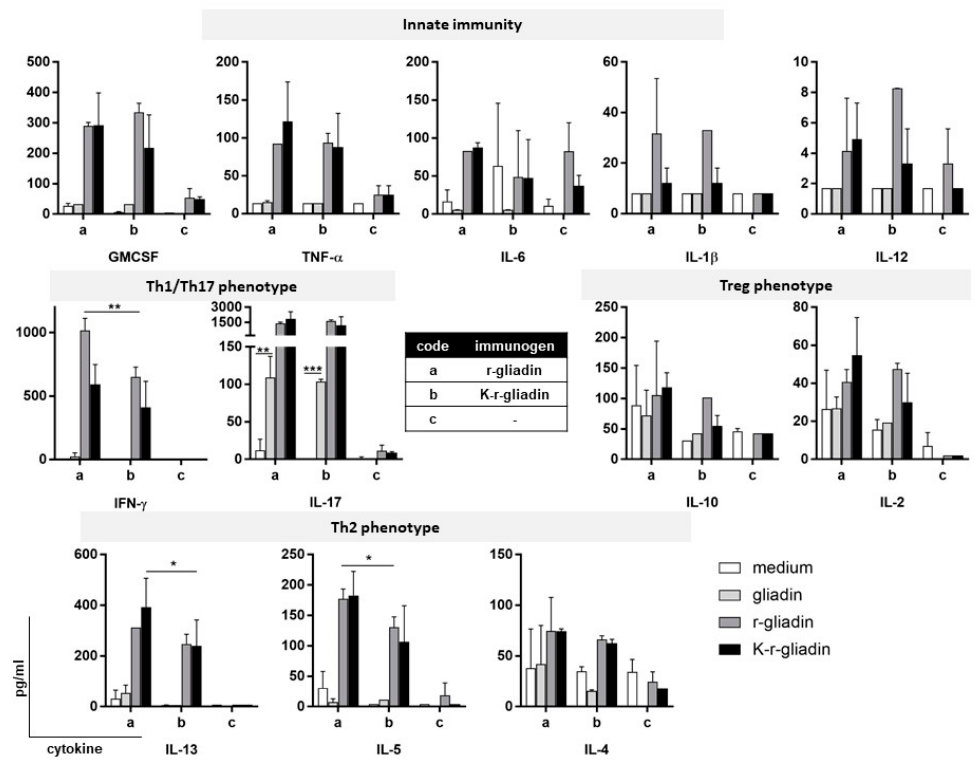
Figure 2. Intestinal cytokine secretion of r-gliadin in DQ8 tg mice. Mice were intranasally administered r-gliadin or K-r-gliadin along with CT. Antigen-specific cytokine expression was assessed by culturing MLN cells from immunized mice for 72 h with the different antigens ( n = 3). Supernatants were then assayed by multiplex assay. Values are presented as mean ± SD. The results are representative of three independent experiments. *, p < 0.05; **, p < 0.01; and ***, p < 0.001.